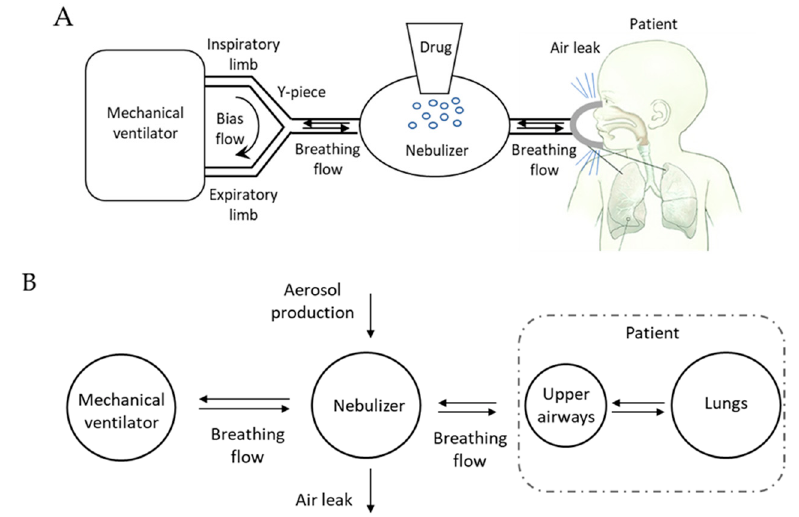
Figure 1. Architecture of the model. ( A ) Schematic representation of the set-up for neonatal applications during noninvasive respiratory support, where the nebulizer is placed between the Y-piece and the patient. The bias flow mentioned represents the flow of fresh breathing gas responsible for the maintenance of the pressure needed. ( B ) The compartmental model used to describe the system in which the compartment and flows are reported.